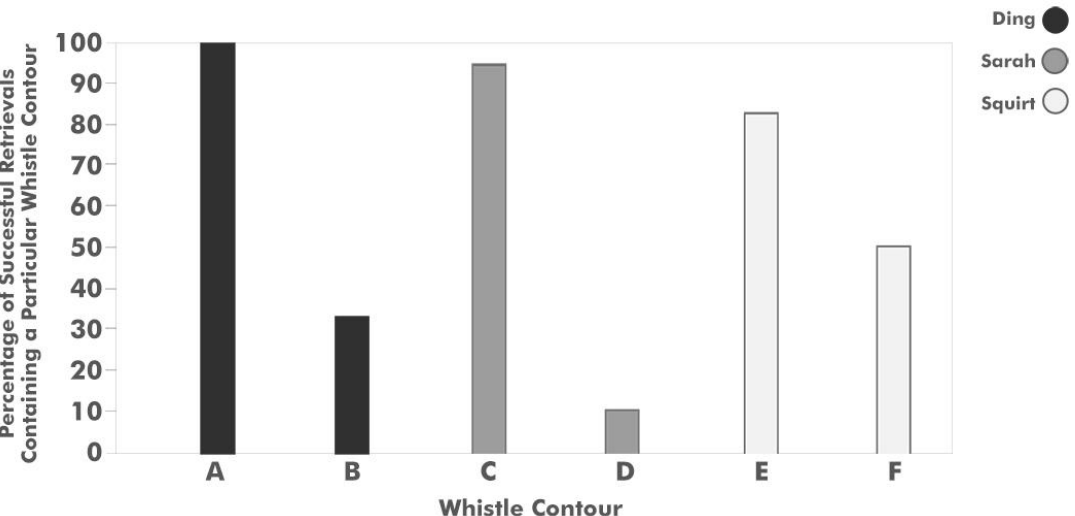
Figure 4. Percentage of successful retrievals containing a specific whistle contour used by one of the mothers in the calf retrieval